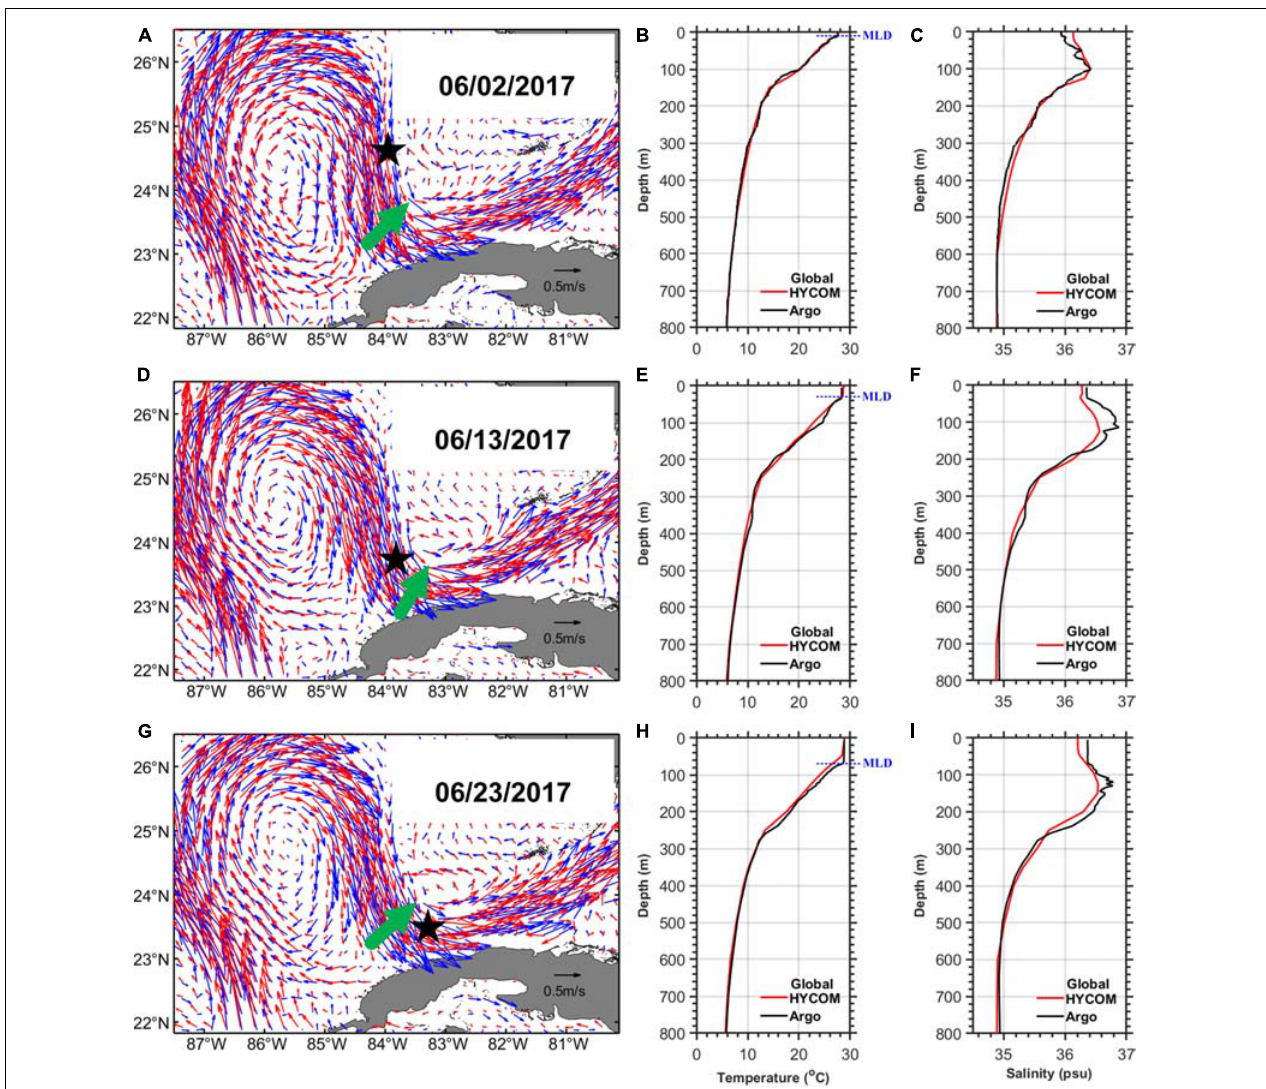
FIGURE 3 | Comparison of surface current distributions (left column; A,D,G ) from altimetry observations (blue vectors) and global HYCOM simulations (red vectors), and comparison of subsurface temperature (middle column; B,E,H ; unit: ◦ C) and salinity (right column; C,F,I ; unit: psu) profiles from an Argo profiling float (black color) and global HYCOM simulations (red color) on June 2, 13, and 23, 2017. In the left column, the location of the CE off the DT is annotated with thick green arrows, and the location of the Argo profiling float located on the edge of the CE is annotated with black pentagrams. The MLDs estimated from the temperature profiles collected by the Argo profiling float are denoted by dashed blue lines in the middle